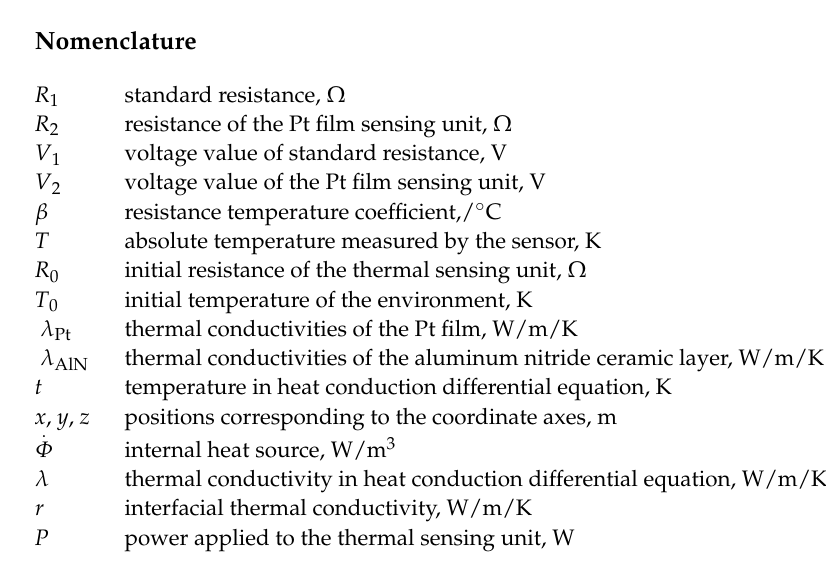
group of out-of-plane thermal measurement; Figure S7: The third group of out-of-plane thermal measurement; Figure S8: Internal chart of the data acquisition card from NI company; Figure S9: The closed look of the testing platform (1, sensor; 2, flame exit; 3, ignition place); Figure S10: Experimental photo of acetylene flame; Figure S11: Labview data acquisition software block diagram; Figure S12: Measured temperature change curve of Pt sensor; Table S1: Simulation temperature results of large voltage side; Table S2: Simulation temperature results of small voltage side; Table S3: Error analysis of simulation temperature results; Table S4: Comparison of simulation experiments; Table S5: The first group of out-of-plane thermal measurement; Table S6: The second group of out-of-plane thermal measurement; Table S7: The third group of out-of-plane thermal